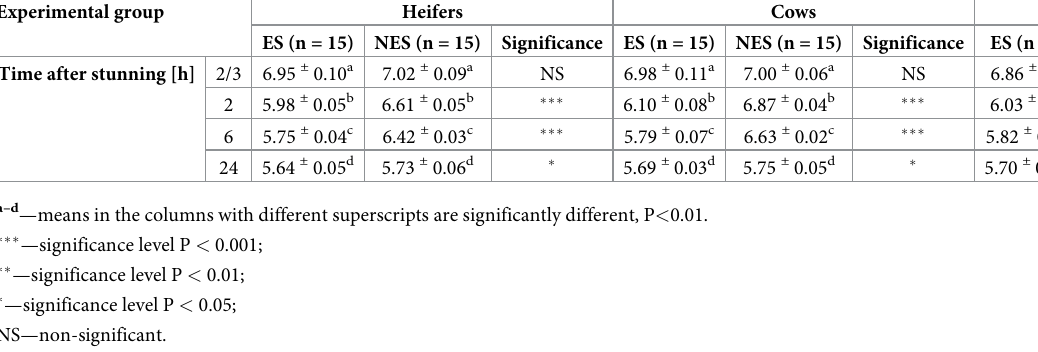
chilling (Table 1) and pH value of ES meat measured 2h post-stunning allows concluding that the use of HVES enables the hot-boning of meat as soon as 2h after stunning without the fear of its cold shortening during consecutive ripening. Moreover, electrostimulation allows elimi- nating the phase of meat retention in the chilling chamber (2.5h/ ca.10˚C) and increasing pro- duction surface [39, 40].